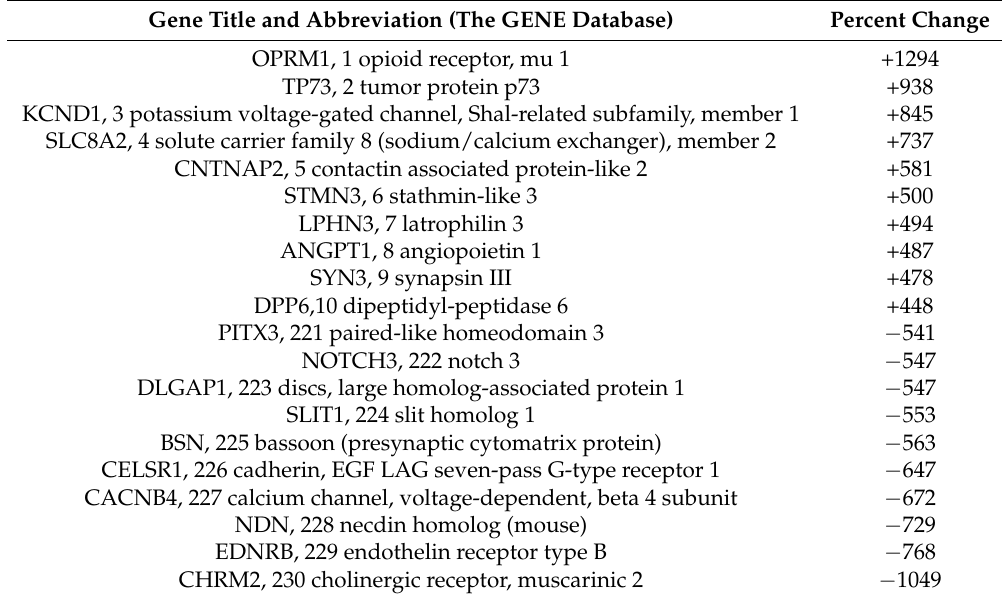
Table 2. Genes Relevant to Neurons’ Function upregulated and downregulated by GHK. Gene Title and Abbreviation (The GENE